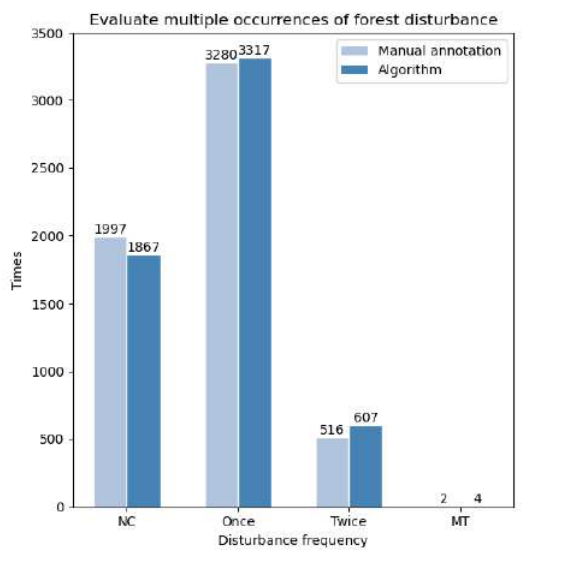
Figure 12. Statistical results on multiple disturbance with 5795 selected test